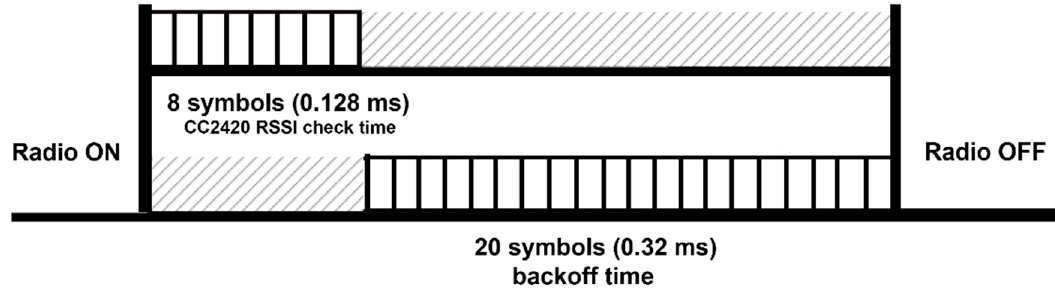
Figure 4. Performance of RSSI status checks based on radio hardware and ContikiMAC.